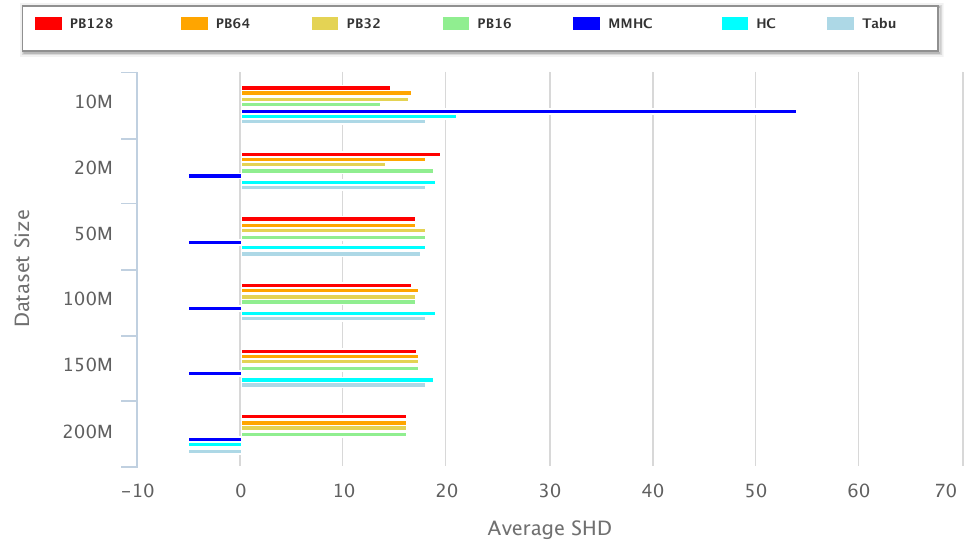
Figure 15. Insurance Dataset Accuracy